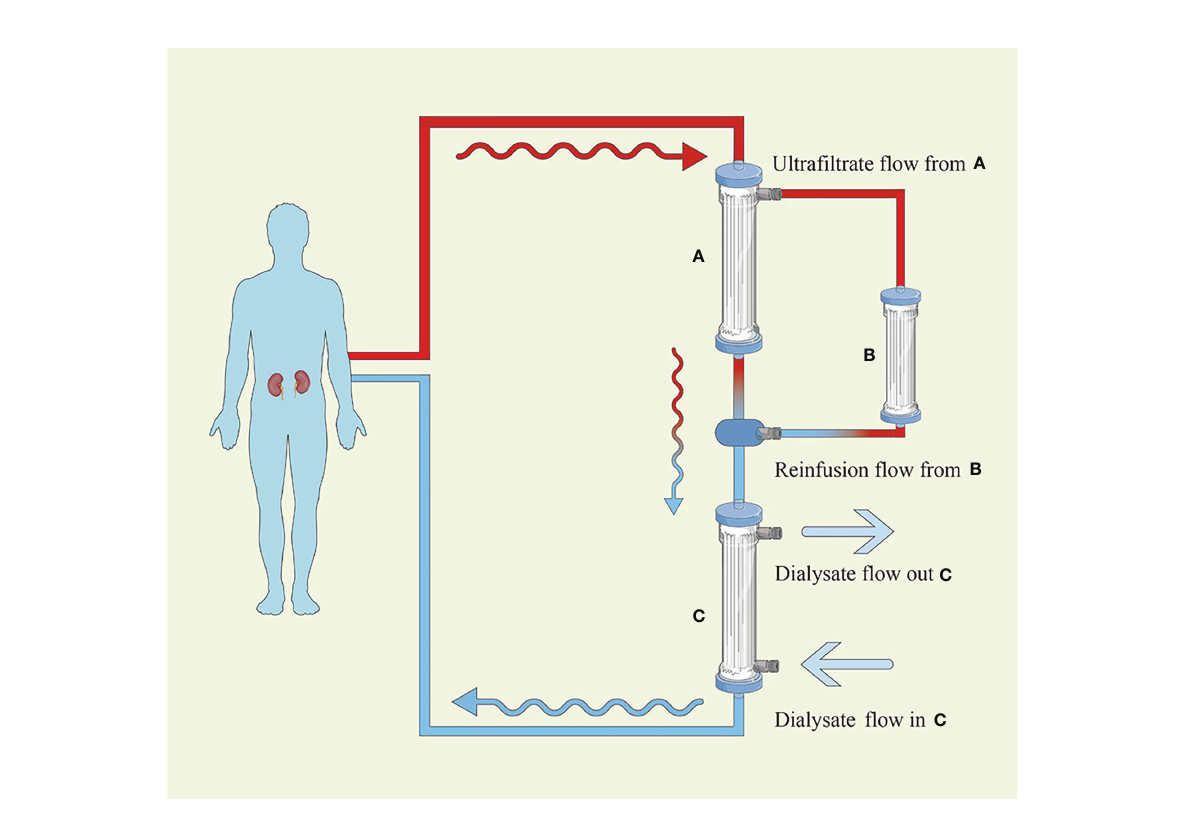
FIGURE 2 Hemodia fi ltration with ultra fi ltrate regeneration by adsorption in resin. (A) High-permeability fi lter with a polyphenylene membrane surface of 0.7 m 2 (B) Resin cartridge with a high af fi nity for k and l (C) Low-permeability fi lter with a polyphenylene membrane surface of 1.7 m 2 . The blood fl ows into the A fi lter initially, where convection is performed, and the produced ultra fi ltrate transits the B cartridge, where adsorption takes place, before passing through the C fi lter, where diffusion is carried